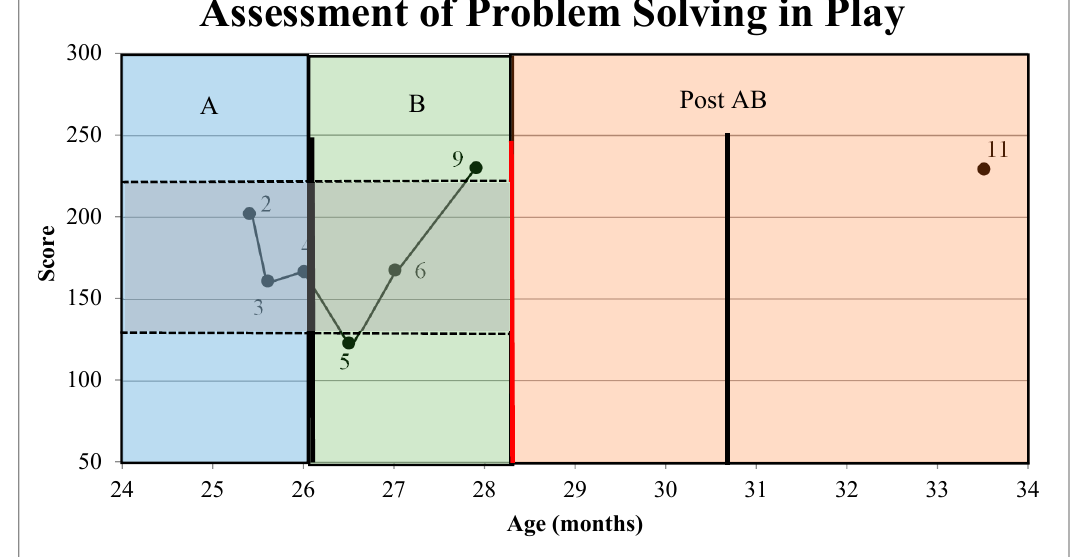
Figure 4. Assessment of Problem Solving in Play Across the AB +1 Phases. Scores of Assessment of Problem Solving in Play (APSP) (reported in frequency APSP/minute) across the AB +1 phases as plotted in reference to the grey shaded +/ − 2 standard deviation band. A = baseline data collection with no intervention, B = Botulinum toxin A/phenol and START-Play physical therapy intervention provided during data collection, Post AB = data point 11 collected via telemedicine (+1). Points 2–9 and point 11 represent administered APSP data points. Points 1, 7, 8, and 10 were omitted from the figure as these data collection days did not include APSP testing due to testing site or child-related limitations. Bolded, black, vertical lines denote Botulinum toxin-A/phenol injections. The bolded, red vertical line denotes treatment ending due to the Covid-19